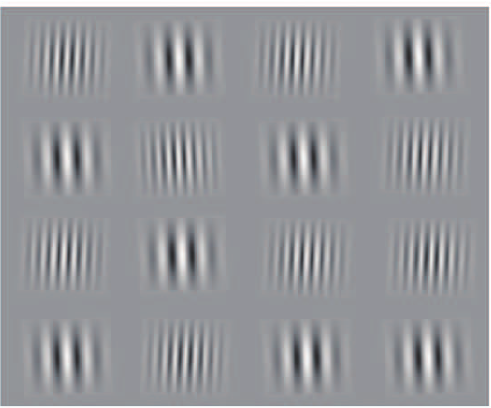
Figure 1. Typical display for the visual search task. Sixteen Gabor patches appeared on the screen. Half of the trials contained a target, which was defined by the combination of orientation and spatial frequency. In this display, the target has a high spatial frequency and is oriented counter-clockwise. It is located at second-row and second- column. The position of the target and the distracters were randomized between trials. doi:10.1371/journal.pone.0021973.g001 Figure 2. Learning curve of the conjunction search task.